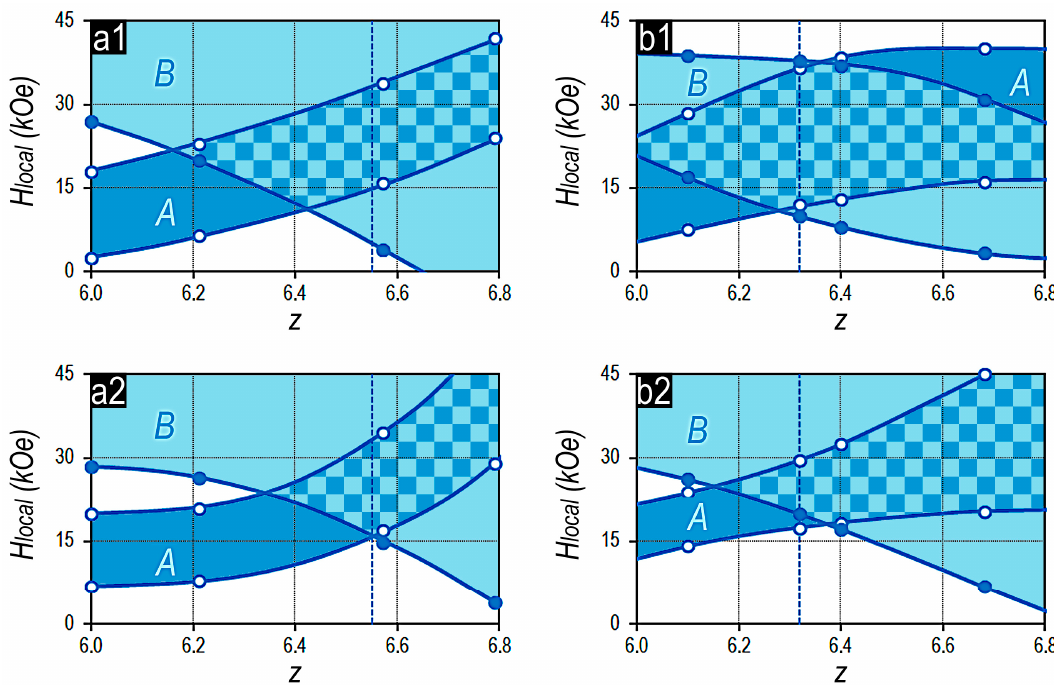
Figure 4. Dependence of the local coercivity of domain walls in structural components A and B upon magnetization of samples from the OFVP-demagnetized state ( a1 , b1 ) and during magnetization reversal from the saturation state ( a2 , b2 ). Data are given for pseudo-single-crystal Sm 1-X Zr X (Co 0.702 Cu 0.088 Fe 0.210 )z samples with x = 0.15 ( a1,a2 ) and 0.19 ( b1,b2 ). Vertical dashed line indicates compositions of samples characterized by equal volume fractions of structural components A and B.